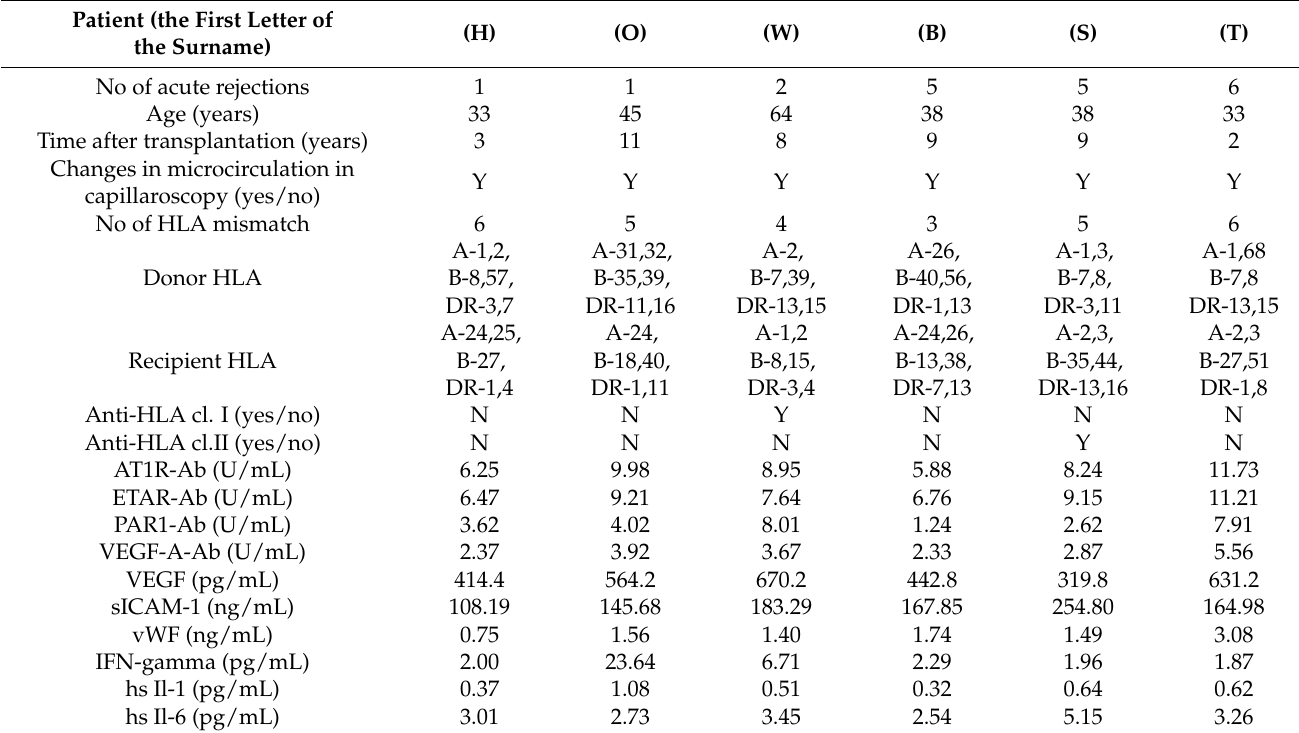
Table 1. Detailed characteristics of hand transplant recipients.